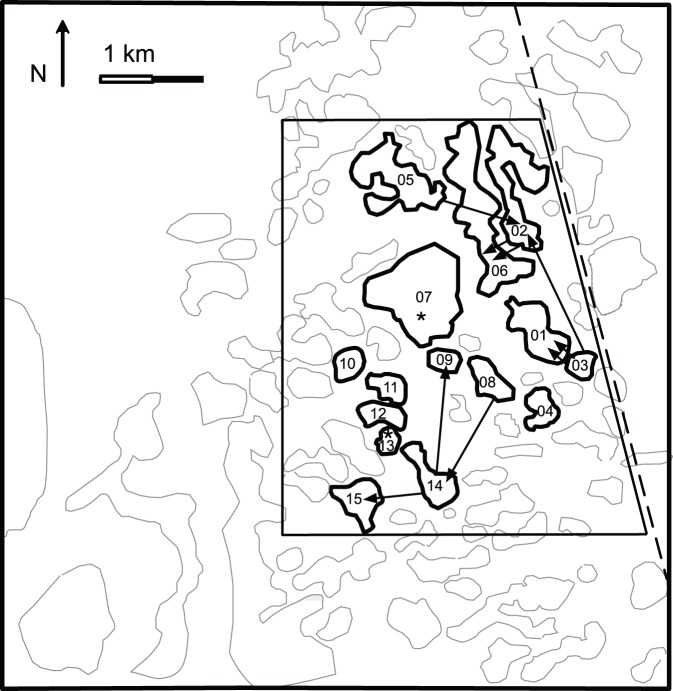
Location of B. candolleana populations (numbered), showing that populations are geographically restricted to dune crests and separated by intervening dune swales.Arrows indicate seed dispersal events. Asterisks in population BC07 and BC13 indicate immigrant for which the most likely source population was not determined.